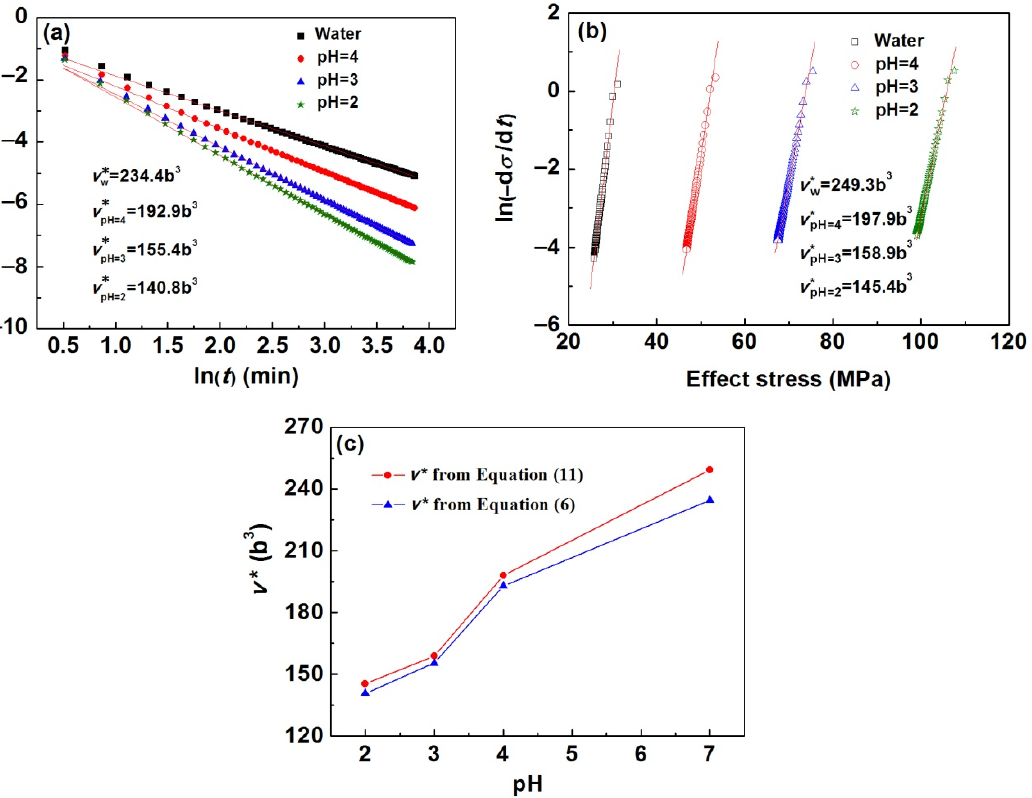
Figure 5. Fitting of the experimental stress relaxation data for FeSi6.5 steel samples in water and H 2 SO 4 solution using Equation (6) ( a ) and Equation (11) ( b ) and the obtained activation volumes are shown as a function of pH values ( c ).